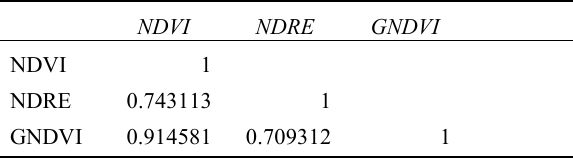
Table 3. Correlation matrix of vegetation